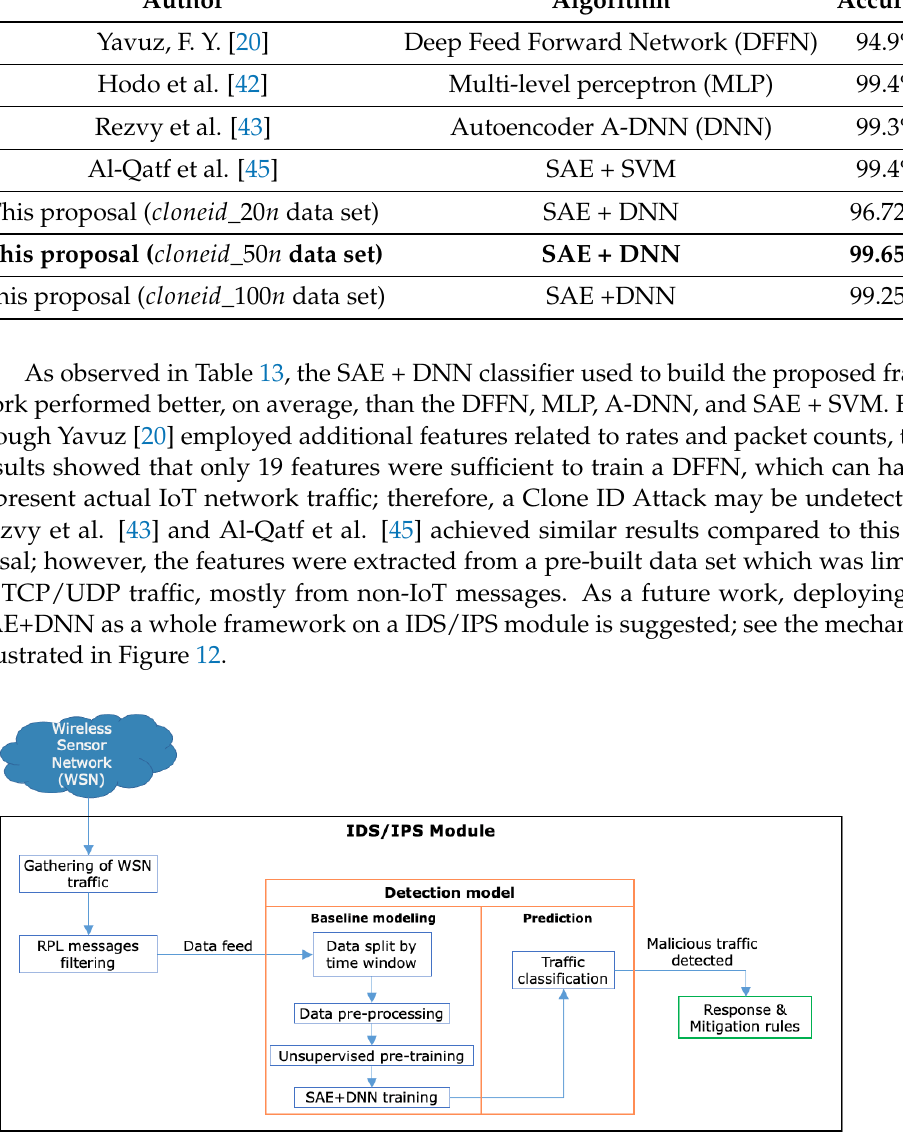
Figure 12. Proposed module integration for an IDS/IPS using the proposed